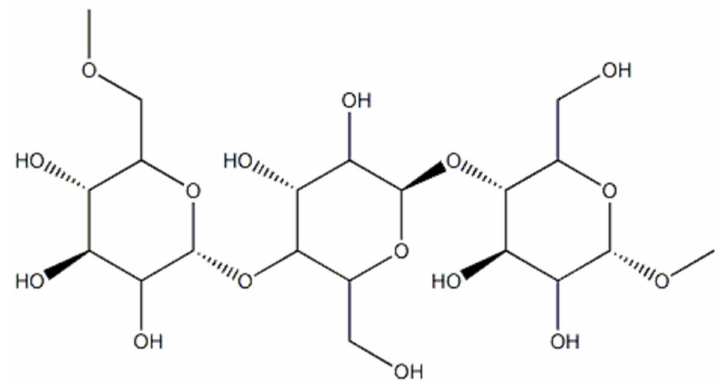
Figure 3. Representation of the pullulan